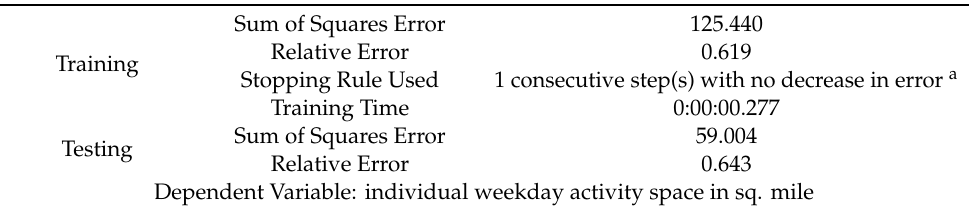
Table 13. Model Summary.